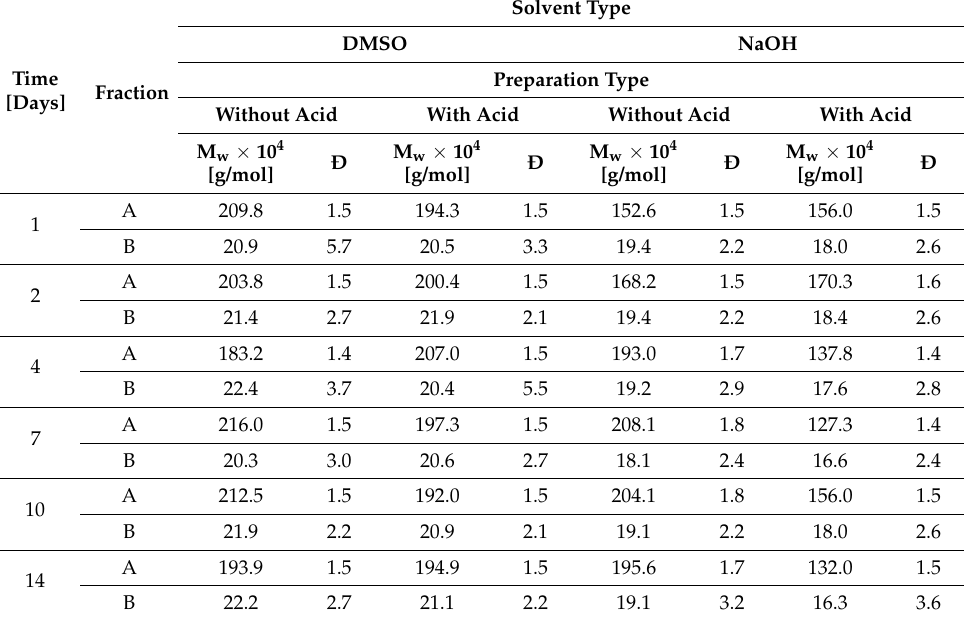
Table 1. Weighted average of molar masses and molar dispersity of starches retained for various periods of time with or without citric acid after dissolution in DMSO or